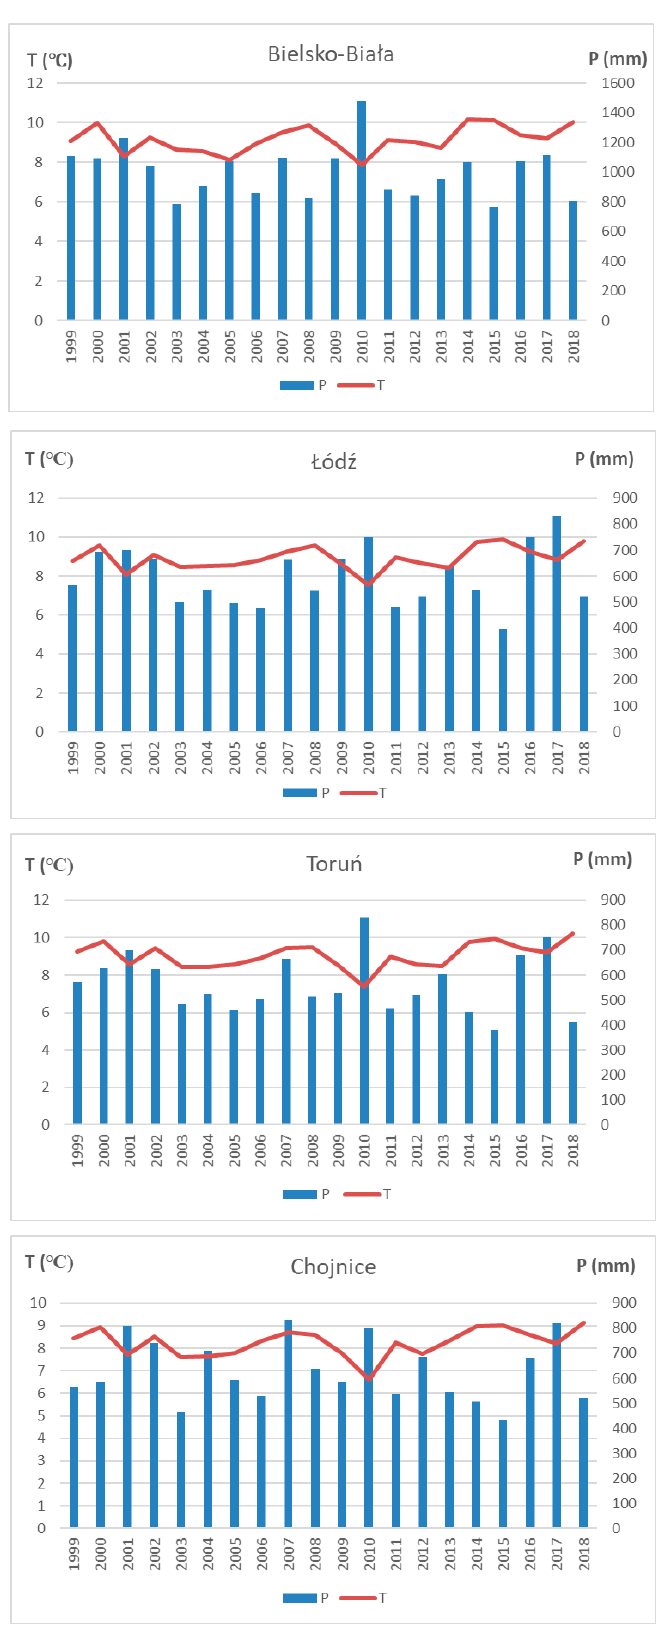
Figure 2. Average annual air temperatures (T) and precipitation (P) at selected meteorological stations in Poland in the period 1999–2018 (based on Institute of Meteorology and Water Management—National Research Institute